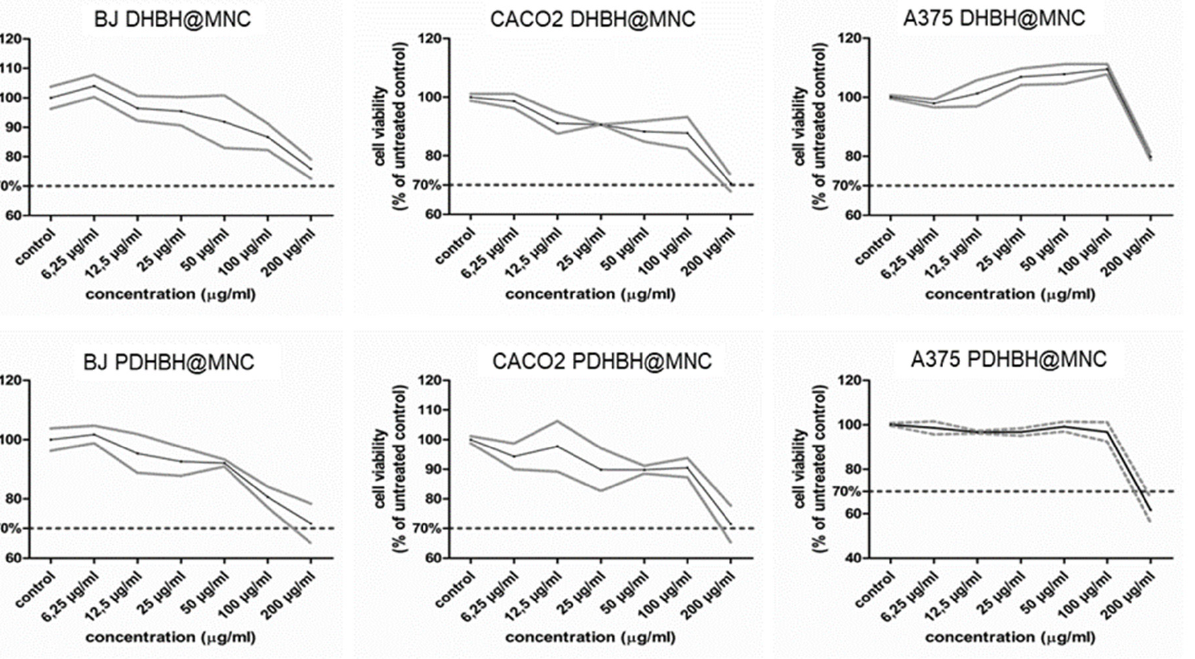
Figure 5. Intrinsic cytotoxicity of DHBH@MNC (upper panels) and PDHBH@MNC (lower panels) were tested against normal fibroblasts (BJ), colon cancer (CACO2) and human melanoma cells (A375) across a range of concentrations (0–200 µg/mL). Data are presented as % of untreated controls, (mean ± standard deviation, n = 3).